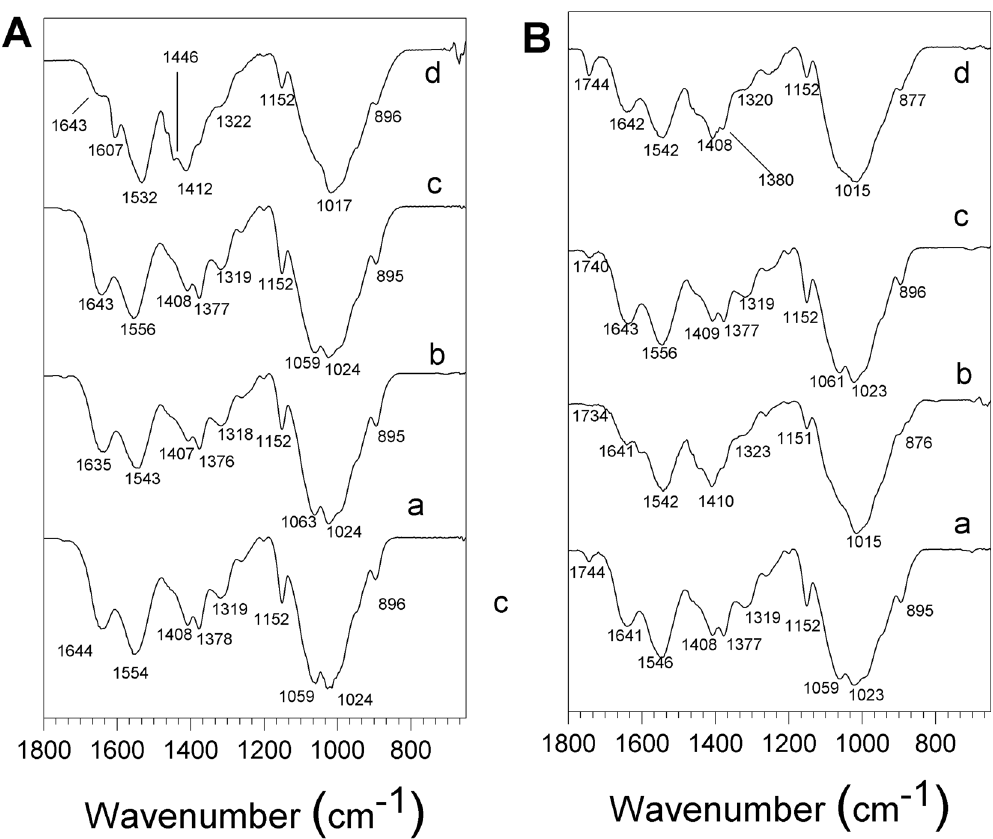
Fig. 4 FTIR-HATR spectra of the different membranes, region 600 – 1800 cm − 1 A composite membranes a BCC1. b BCC2. c BCHA3. d BCHA4. B tri-composite membranes a TC1. b TC2. c TC3. d